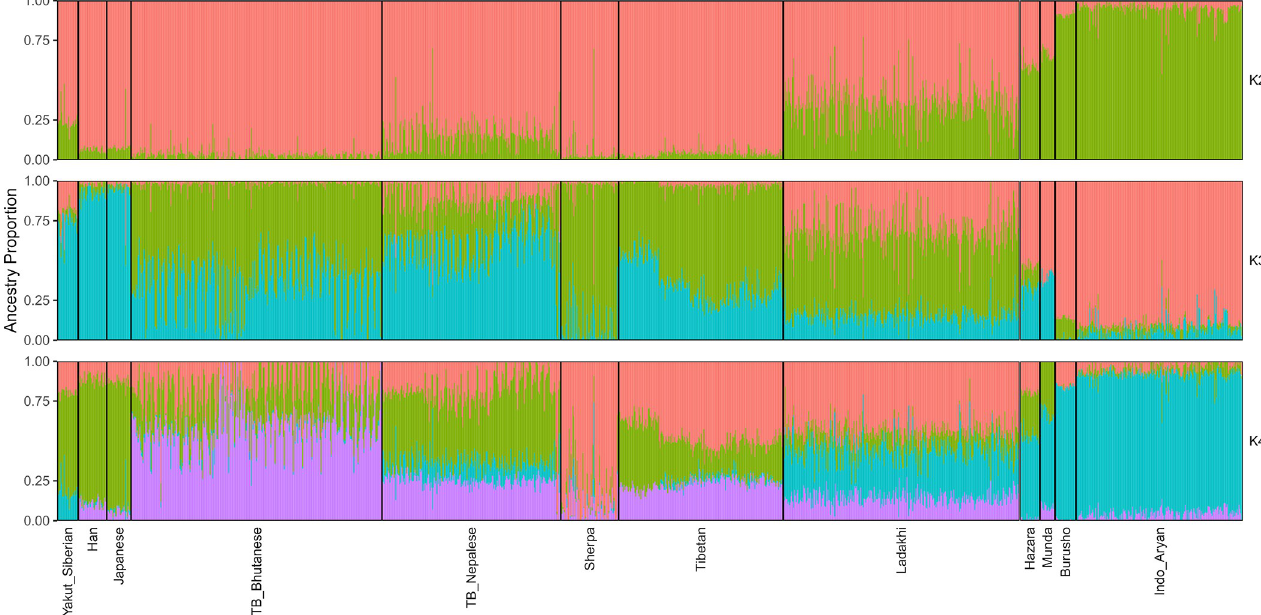
Fig 2. ADMIXTURE analysis of the Ladakhi population. ADMIXTURE analysis for K = 2 (top), K = 3 (middle) and K = 4 (bottom). ADMIXTURE analysis shows Ladakhi contain higher number of Tibeto-Burman ancestries and are relatively closer to Tibetans.